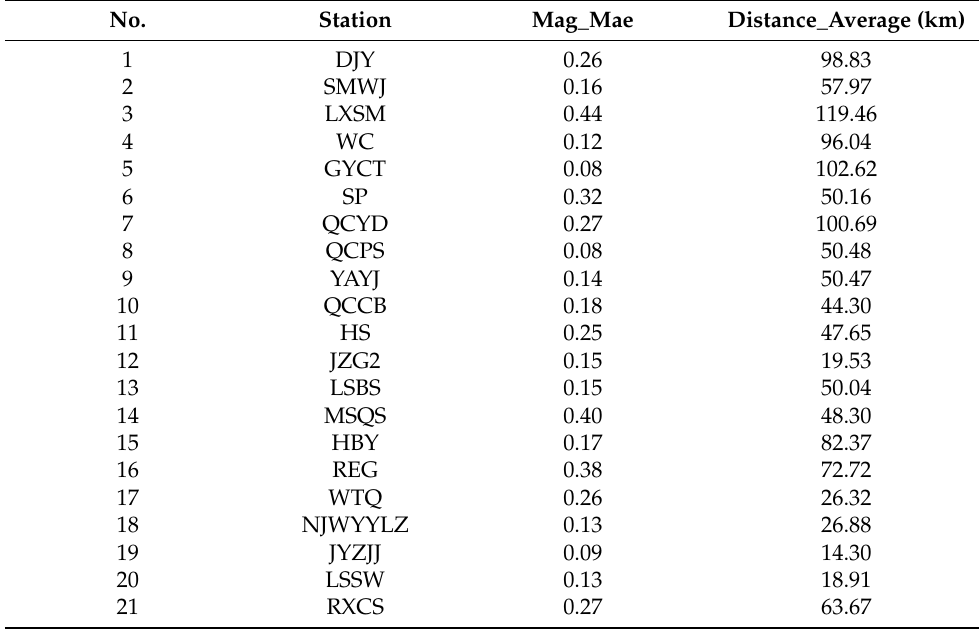
Table A5. Prediction results of LSTM model for magnitude and epicenter on area1.